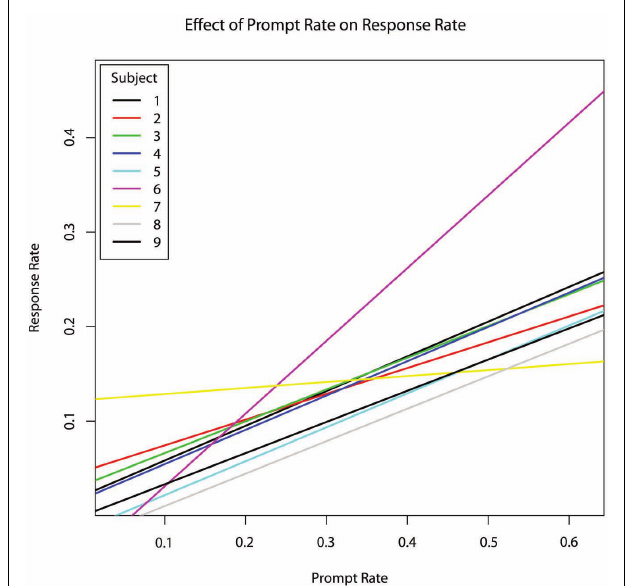
FIGURE 3 |The effect of therapist prompt rate within each session on subject response rate within each session, per second, controlling for age.